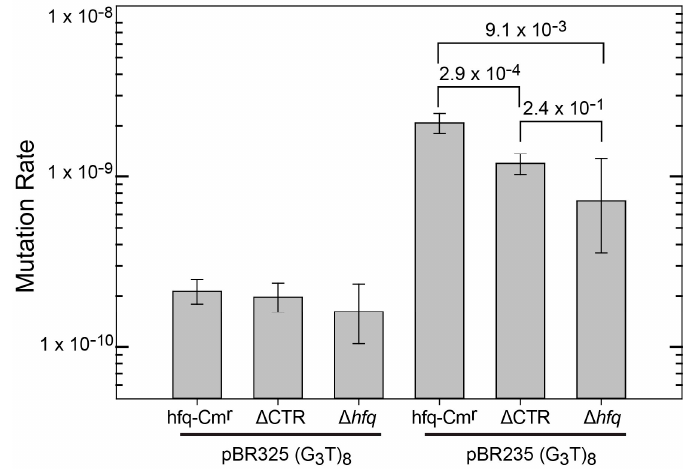
Figure 1. Mutation rates for (G 3 T) 8 repeats in plasmids pBR325 and pBR235 in MG1655 hfq -Cm r (reference strain), MG1655 HfqNTR72-Cm r ( ∆ CTR), and MG1655 hfq ::Cm r ( ∆ hfq ) [38]. Mutation rates were determined as described under Materials and Methods. Data for MG1655 hfq -Cm r and MG1655 NTR72-Cm r with both pBR325 and pBR235 represent results from two independent Luria–Delbrück fluctuation analyses. Results for plasmids in MG1655 ∆ hfq ::Cm r represent a single Luria–Delbrück fluctuation analysis. Error bars represent 84% confidence intervals. Numbers represent false discovery rates.